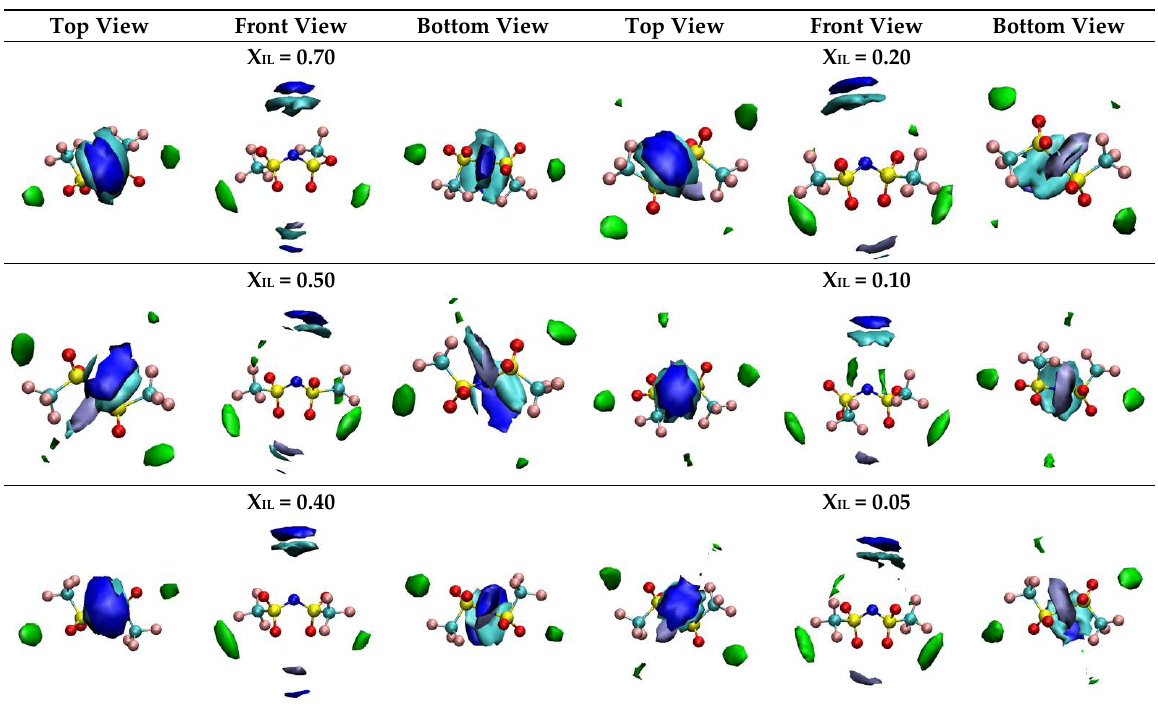
Figure 15. Selected spatial distribution functions around the [N 1 2OH 2OH 2OH ] + cation in aqueous mixtures of [N 1 2OH 2OH 2OH ][NTf 2 ] at 300 K. The red and green colors represent N and F atoms of anion, respectively, and light blue depicts the water O atom. The isosurface value is 70% of the maximum number density.